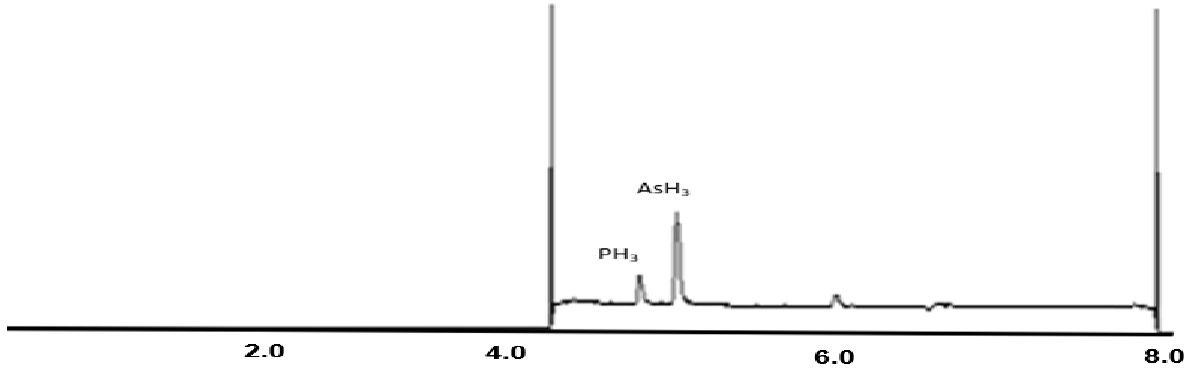
Figure 2. Arsine chromatogram.